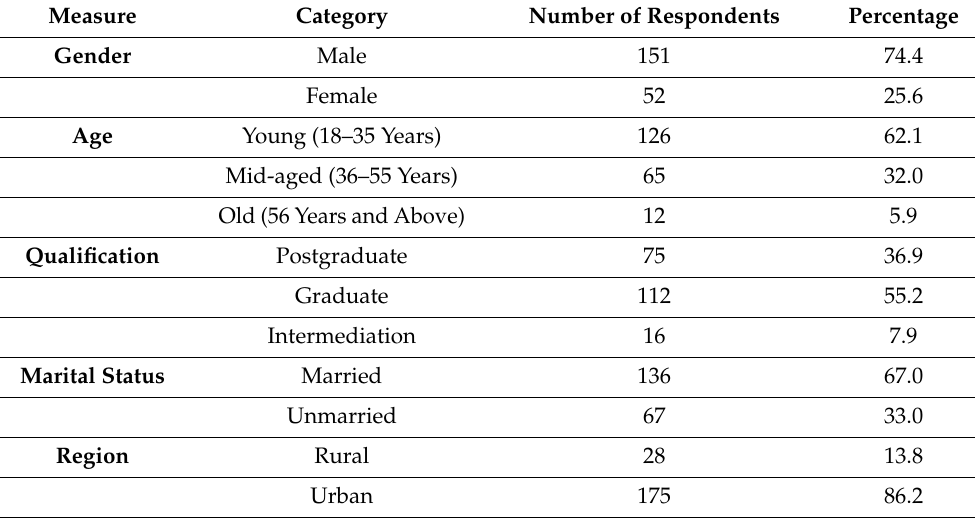
Table 3. Demographic Profile of